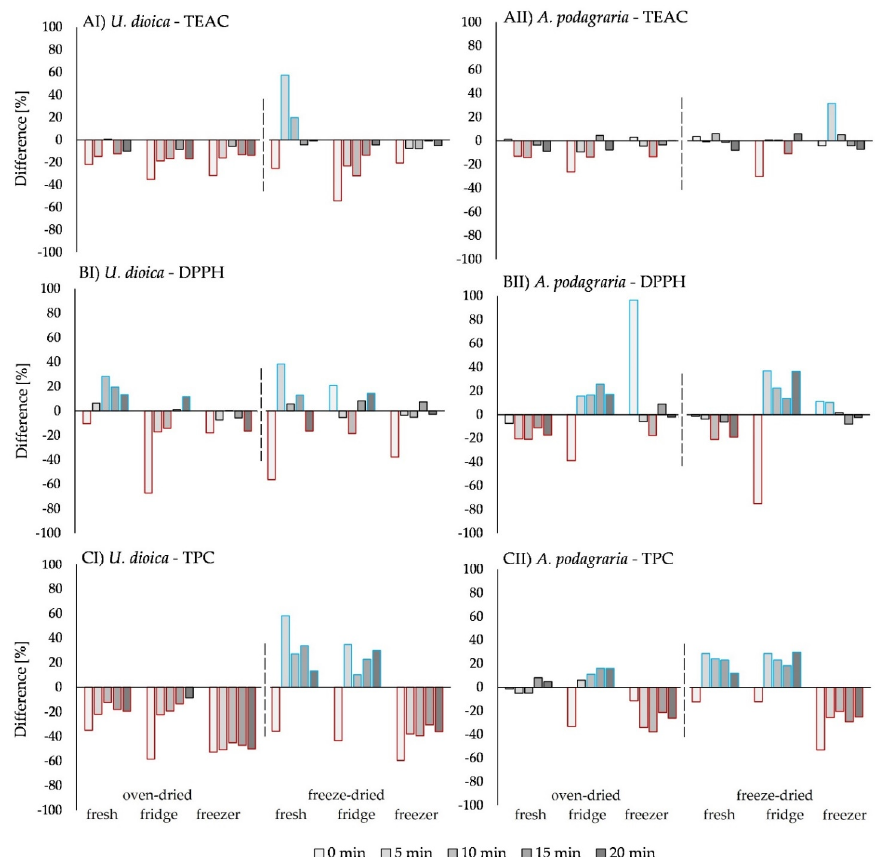
Figure 5. Difference in percent [%] of the experimental antioxidant activity from the calculated sum of the plant sample’s individual antioxidant activities and the 5-caffeoylquinic acid of I) Urtica dioica L. and II) Aegopodium podagraria L. using ( A ) TEAC, ( B ) DPPH, and ( C ) TPC assays. Synergistic effects over +10% are marked with blue frames, antagonistic effects over − 10% are marked with red frames.